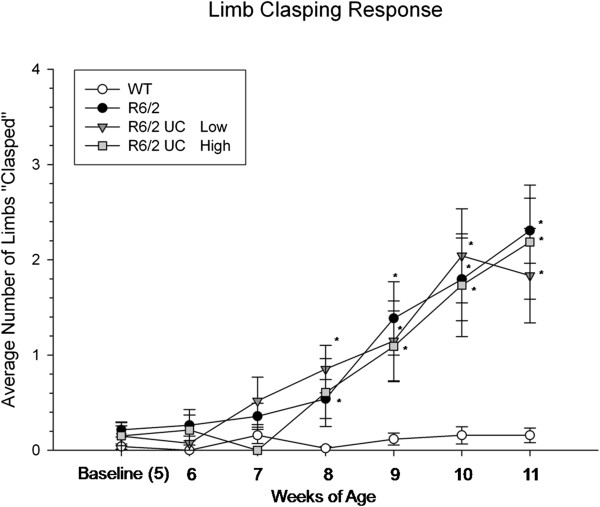
Limb-clasping of R6/2 mice following umbilical cord mesenchymal stem cell (UC MSC) transplantation. Untreated R6/2 mice had significantly more limb-clasping responses than did WT mice, starting at eight-weeks of age, with this impairment continuing for the duration of the study. Mice receiving either low- or high-passaged UC MSCs were similar to untreated R6/2 mice. (Note: *significant from WT; #significant from R6/2; †significant from high-passage BM MSCs). Line graph represents mean value; error bars represents SEM. BM, bone marrow; SEM, standard error of the mean; WT, wild type.